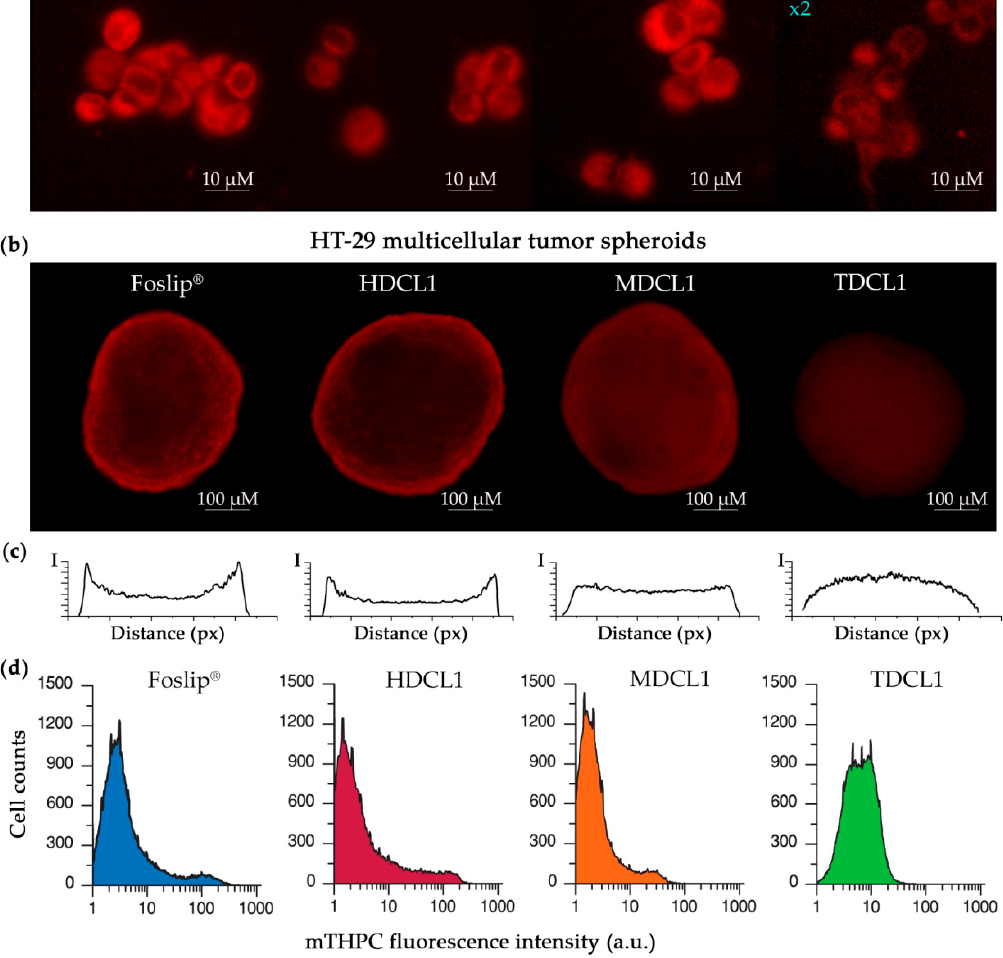
Figure 4. ( a ) Fluorescence images of mTHPC in different formulations in HT-29 monolayer cells 3 h post-incubation. ( b ) Fluorescence patterns of mTHPC in different formulations in HT-29 MCTSs 24 h post-incubation. ( c ) Linear profiles of mTHPC fluorescence intensity in HT-29 MTCSs treated by different mTHPC liposomal formulations for 24 h. ( d ) Histograms of mTHPC fluorescence in function of cell counts in HT29 spheroids after 24 h incubation with different mTHPC formulations. Log scale mTHPC fluorescence is shown on the x-axis. mTHPC concentration for all samples was 4.5 μ M.